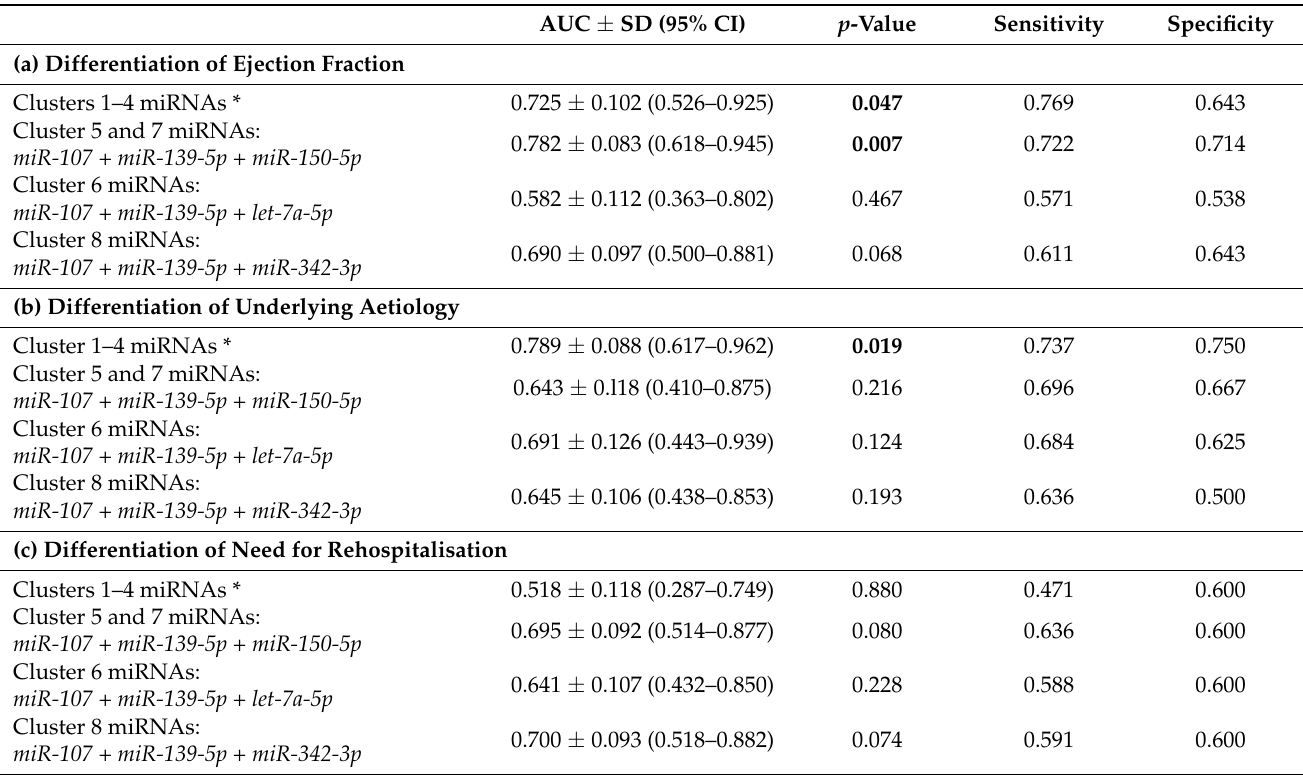
Table 2. ROC curve analysis of miRNAs according to their cluster